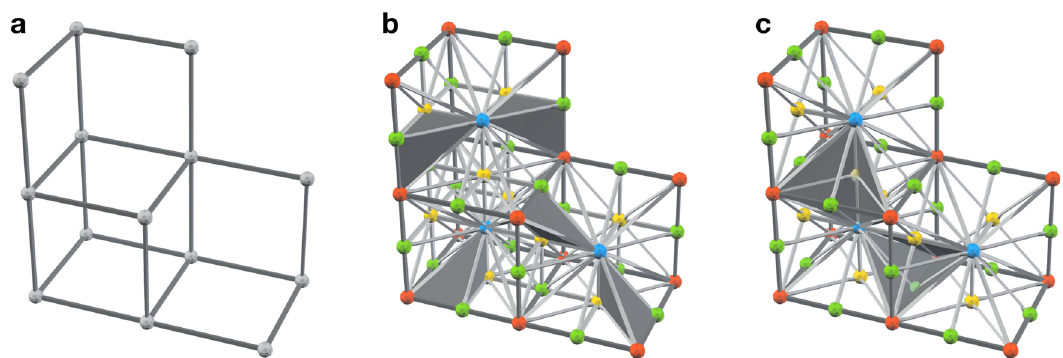
Fig. 5 | A procedure for constructing a colorable octahedral lattice J oct . a We